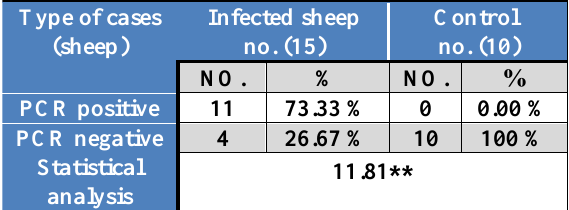
** Significant differences (P≤ 0.01).